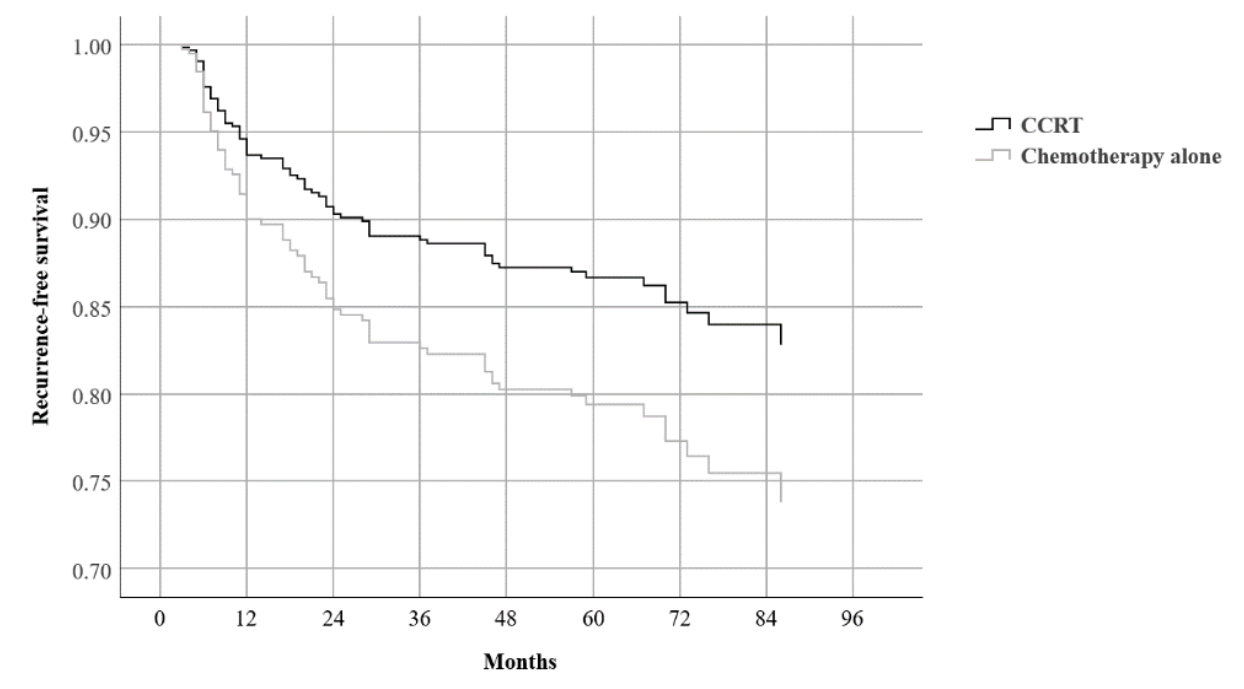
Figure 3. Adjusted recurrence-free survival curve according to the type of adjuvant treatment in patients with an absolute lymphocyte count > 2074.0/µL ( n = 345). CCRT, concurrent chemoradio- therapy.